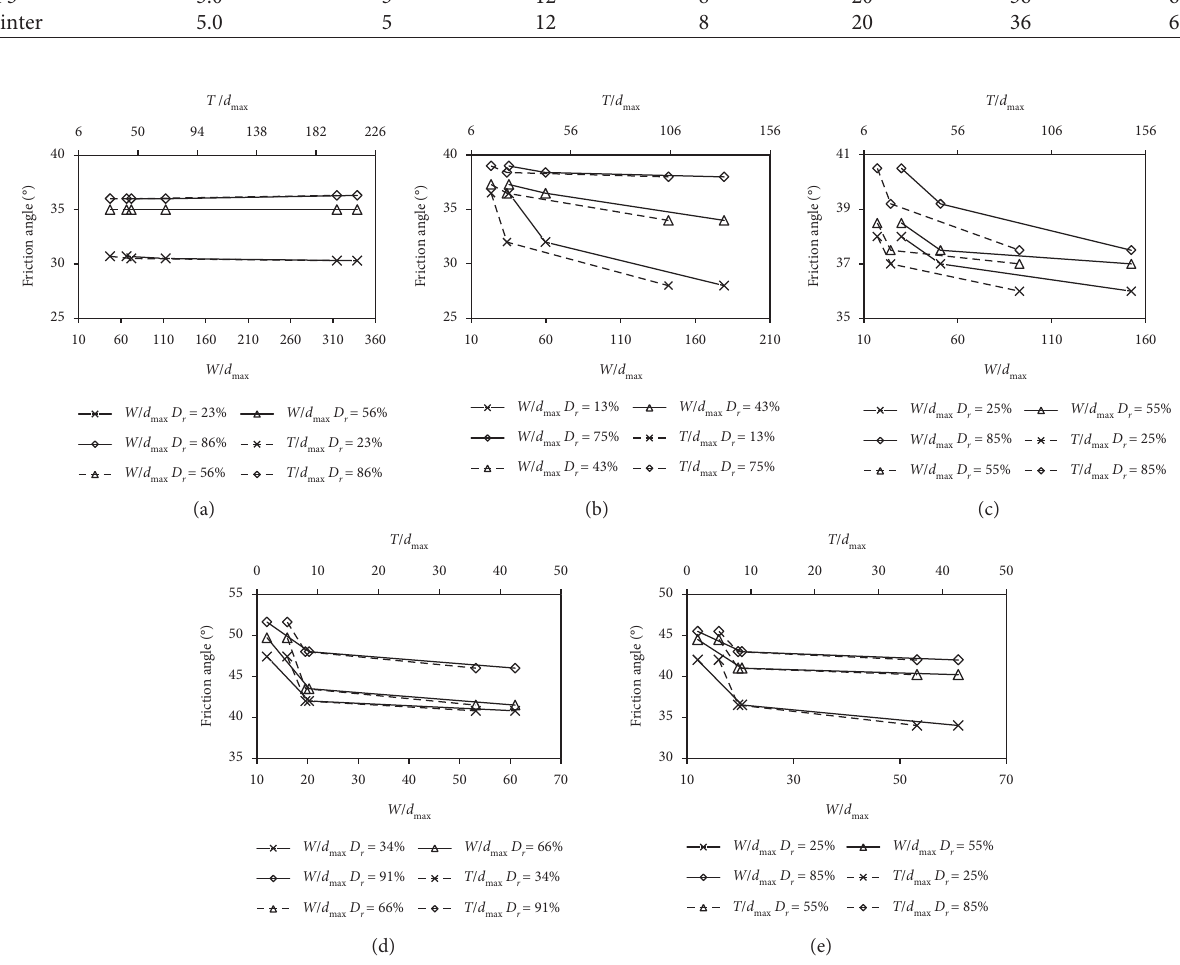
Figure 13: Variation of the friction angle in terms of specimen width and thickness to d densities (data taken from [123]): (a) Ottawa sand, (b) FHWA (brown mortar), (c) Morie, (d) winter, and (e) gravel pack